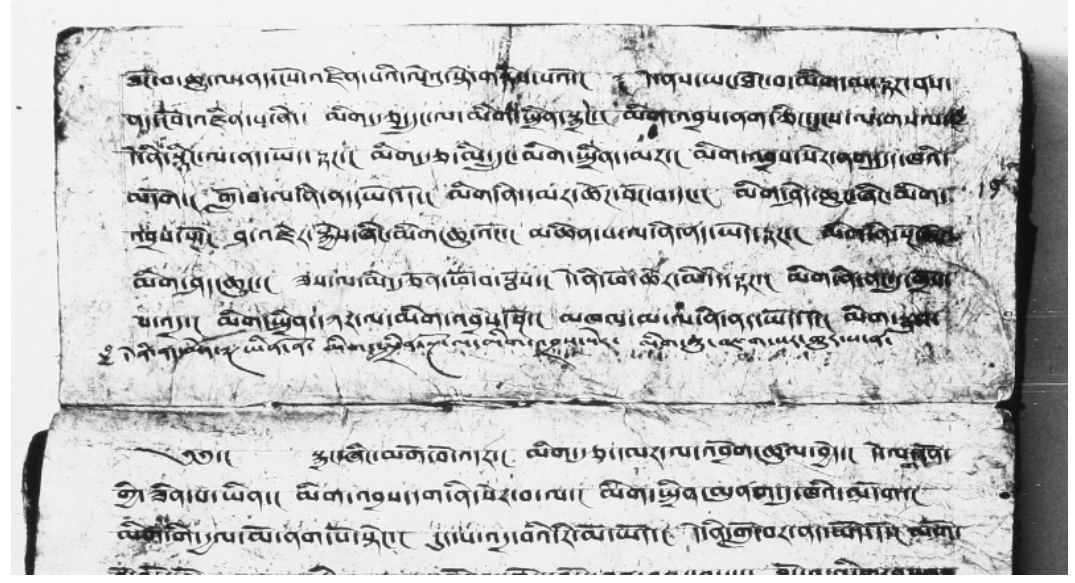
Figure 2. Description of eye diagnosis.